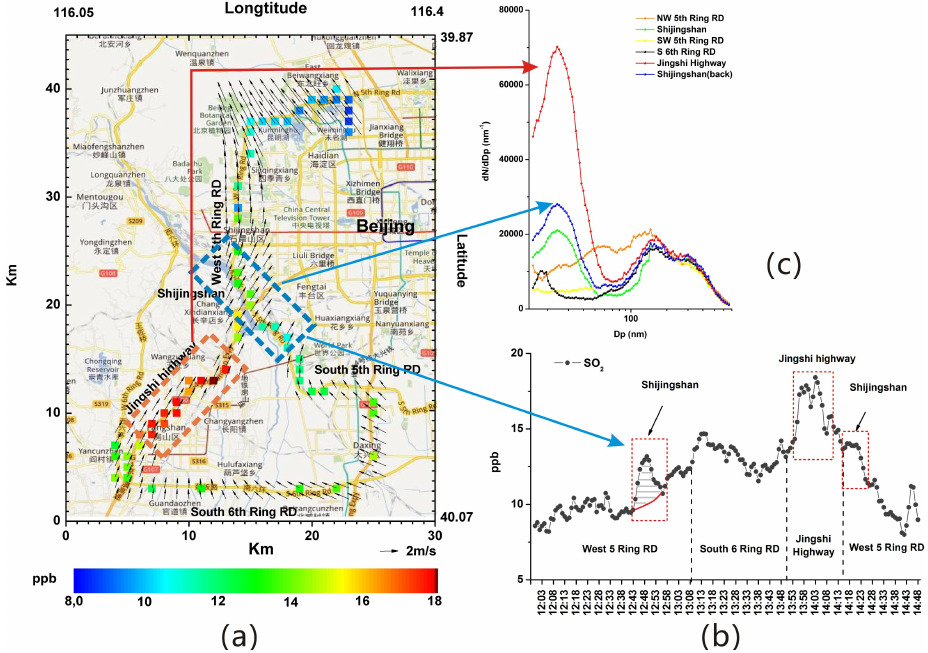
Fig. 7. (a) SO 2 spatial distributions and wind field by WRF with 1 × 1km 2 grids resolution in southwestern areas of Beijing on 6 August 2008. The dashed areas on the left and middle of the figure represent Jingshi Highway and Shijingshan district where high peak values were observed; (b) time series of SO 2 variations on 6 August, where the red plots and the black shades show the regional background and local emission of SO 2 across the 5th Ring Road. (c) SMPS particle size distributions measured in seperated areas of the route on 6 August. The red and blue arrows display the Jingshi Highway and Shijingshan districts in (a) corresponding to the SO 2 peak values in (b) and the particle size distributions in (c) . Table 4. The annual SO 2 emission rates in provinces surrounding Beijing from Beijing EPB and INTEX-B 2006 inventory and the extrapo- lated SO 2 annual flux in our study. Province SO 2 non-control period SO 2 control period Sources (Ggyr − 1 ) (Ggyr − 1 ) 200 70 Beijing EPB,